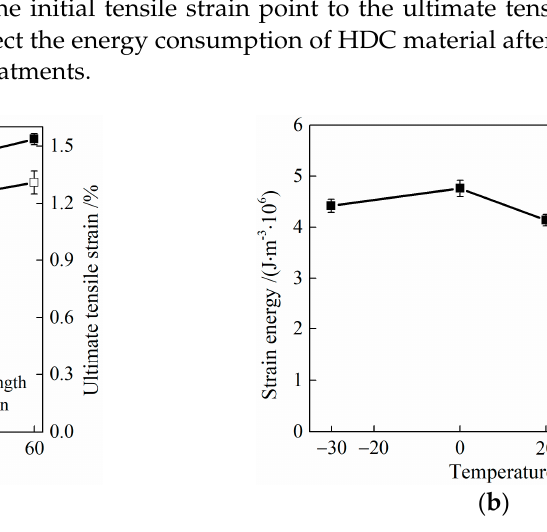
Figure 13. Relationship between feature parameters of tensile property and temperature for HDC. ( a ) Ultimate tensile strength and ultimate tensile strain. ( b ) Strain energy. ( a ) Ultimate tensile strength and ultimate tensile strain. ( b ) Strain